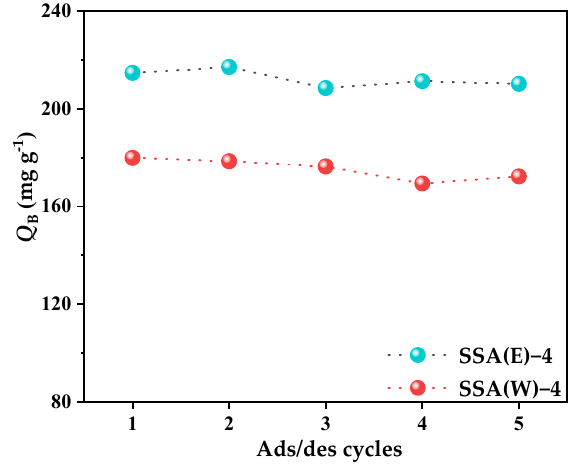
Figure 7. Reusability of SSA(E) − 4 and SSA(W) − 4 in the cyclic operations.